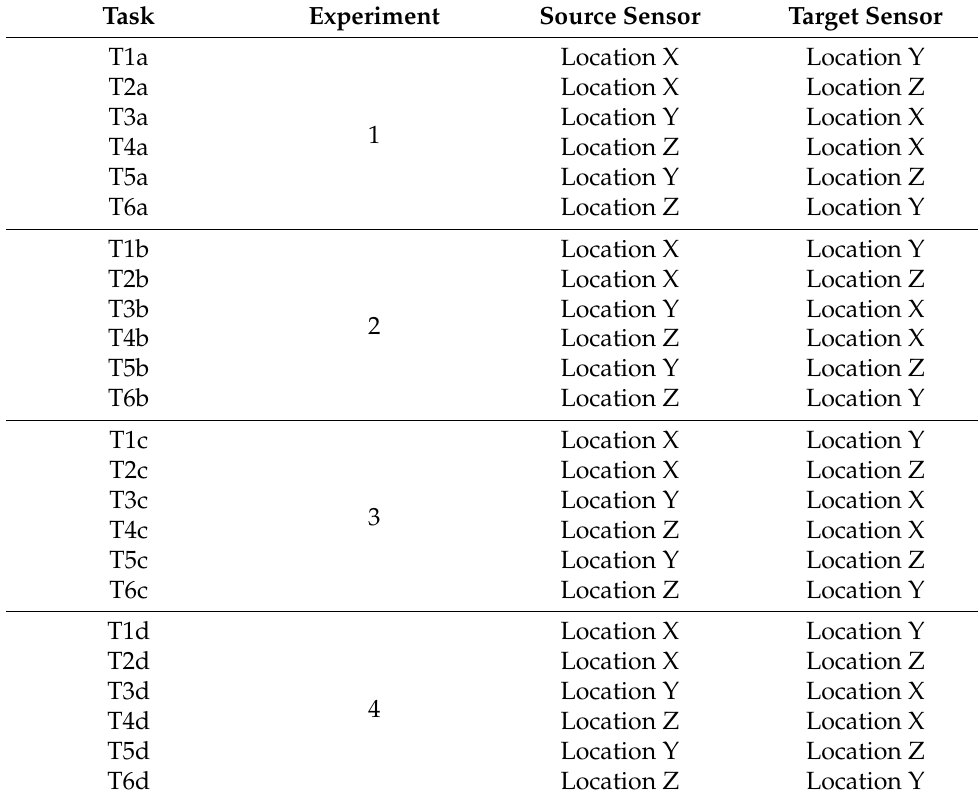
Table 2. Transfer